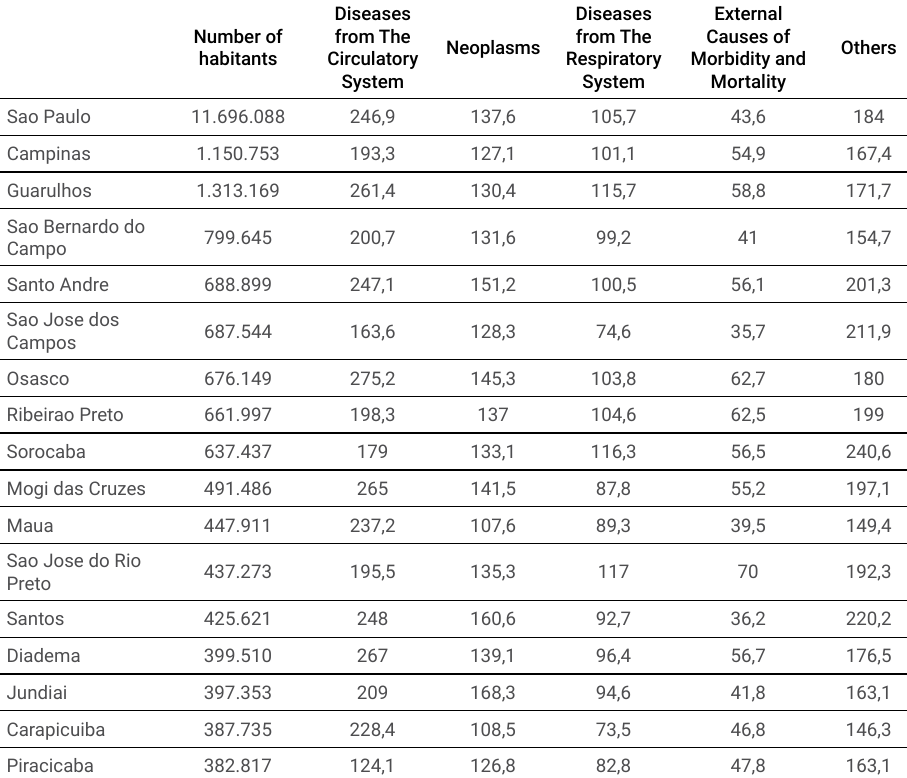
Table 2. ASMR’s in the 17 most populous cities from Sao Paulo state according to ICD – 10 chapters. Cities with more than 380,000 habitants. Diseases Number of from The habitants Circulatory System